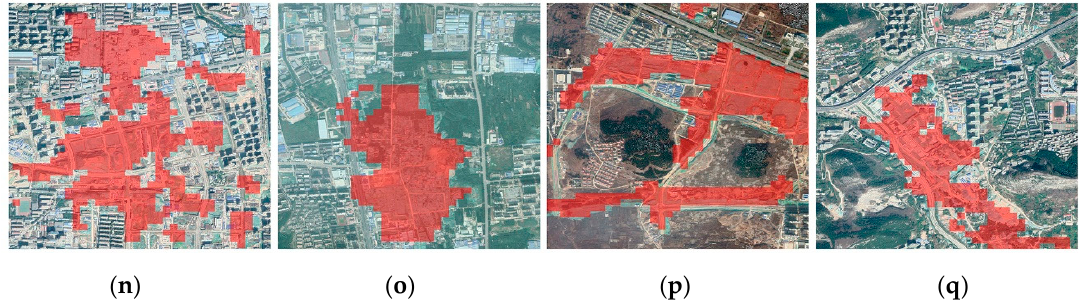
Figure 8. Mapping results of green plastic cover for ( a ) the whole study area; ( f ) sub-region I; ( g ) sub-region II; ( h ) sub-region III; ( i ) sub-region IV; ( n ) sub-region V; ( o ) sub-region VI; ( p ) sub-region VII; and ( q ) sub-region VIII. True color images for ( b ) sub-region I; ( c ) sub-region II; ( d ) sub-region III; ( e ) sub-region IV; ( j ) sub-region V; ( k ) sub-region VI; ( l ) sub-region VII; and ( m ) sub-region VIII.